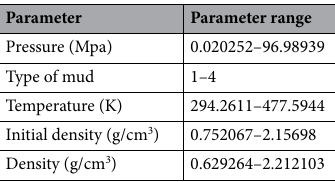
Table 1. Range of input affecting parameters and the